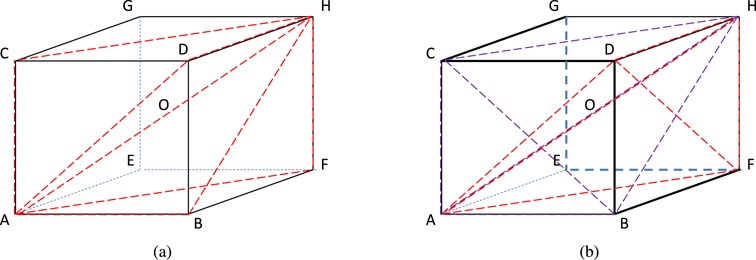
Regions of identifiability and non-identifiability. (a) The intersection of all triangles formed by A(=DWV) and H(=VDV-1) and any one of B, C, D, E, F and G is the line AH. The red lines demarcate these triangles for B, C, D and F. Essentially, all points y are thus identifiable. (b) When two recombinants are sought, points near AH are not identifiable; for example, those points in the intersection of tetrahedra ABCH (purple) and ADFH (red). Points near the darker perimeter edges are identifiable.